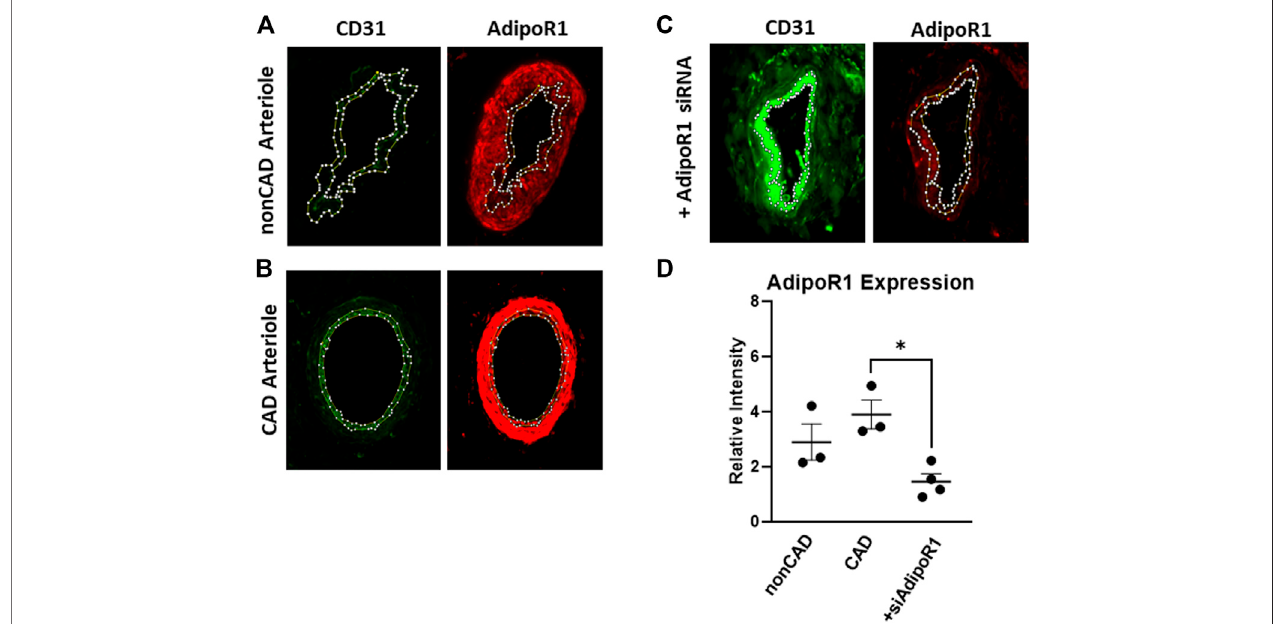
FIGURE1| AdipoR1expression inhumanmicrovessels.Representativeimagesshowingexpression ofCD31(green) and AdipoR1 (red) inarterioles frompatients without CAD (A) , with CAD (B) and arterioles treated with siAdipoR1 (C) . CD31 was used to identify the endothelium to allow for measurement of AdipoR1 in the intimal layer of the vessel. (D) Measured relative intensity of AdipoR1 in all groups. ( n = 3 for nonCAD and CAD, n = 4 for vessels treated with siAdipoR1; 3 nonCAD, 1 CAD), * p < 0.05).